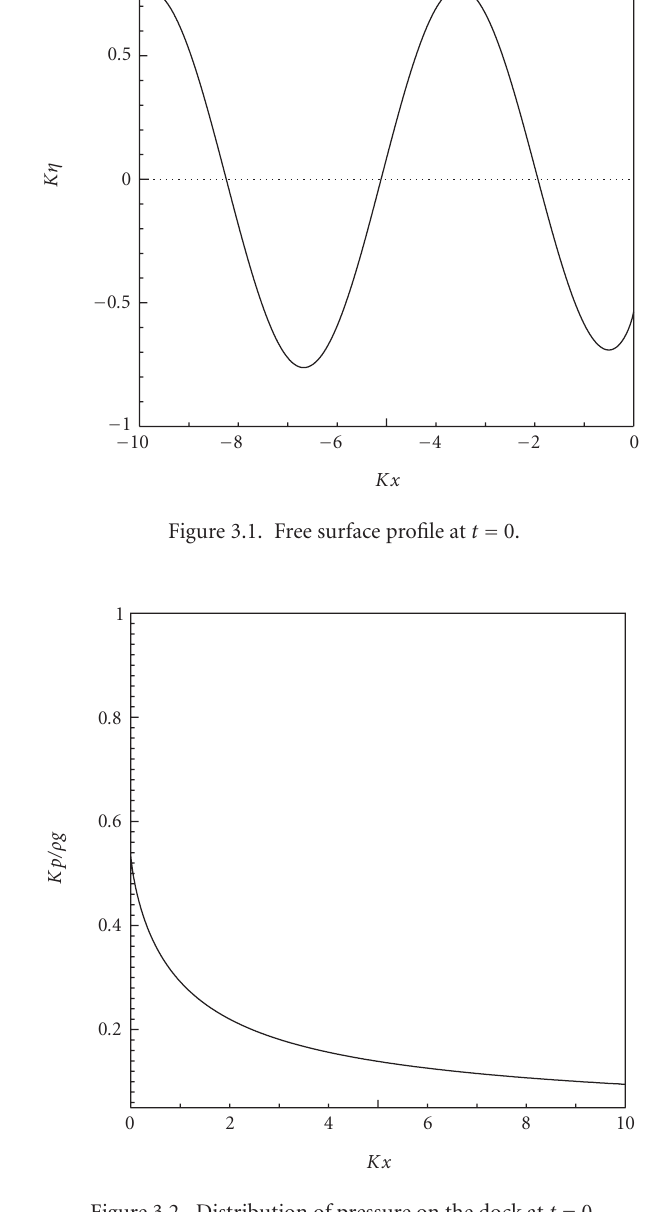
Figure 3.2. Distribution of pressure on the dock at t =